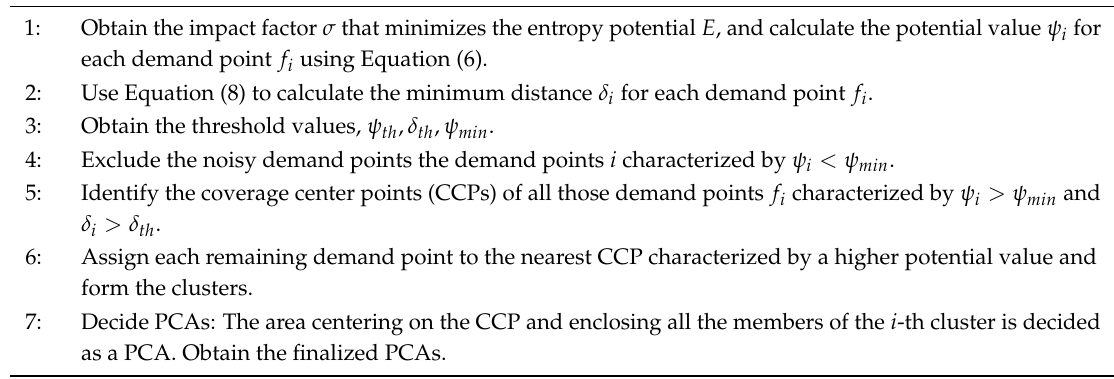
Algorithm 1. PCAs decision algorithm for DBSs